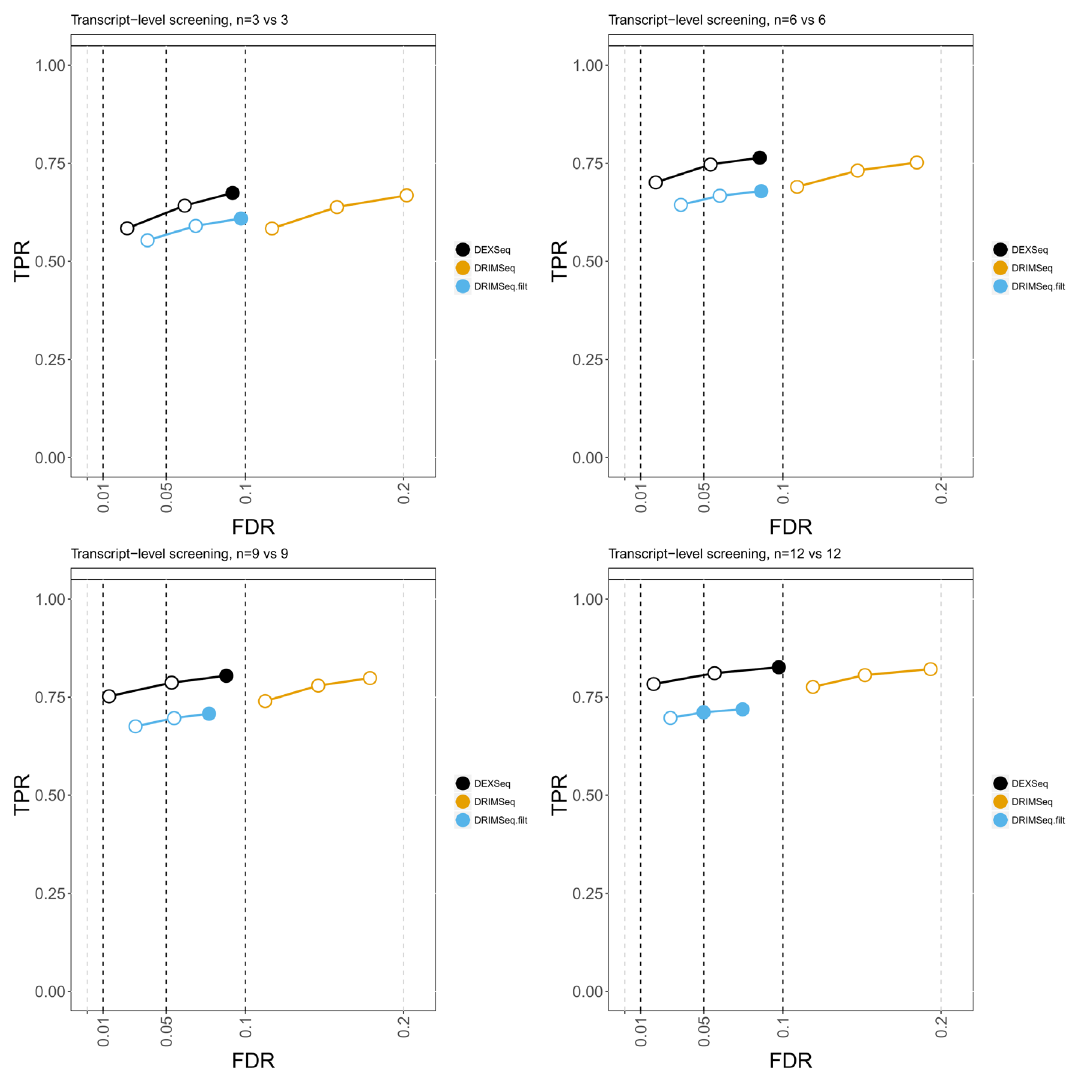
Figure 11. Transcript-level differential transcript usage (DTU) analysis without stage-wise testing, on the “fixed per-gene dispersions” simulation. The four panels are for per-group sample sizes: 3, 6, 9, and 12, as indicated in the title. Circles indicate thresholds of 1%, 5%, and 10% nominal